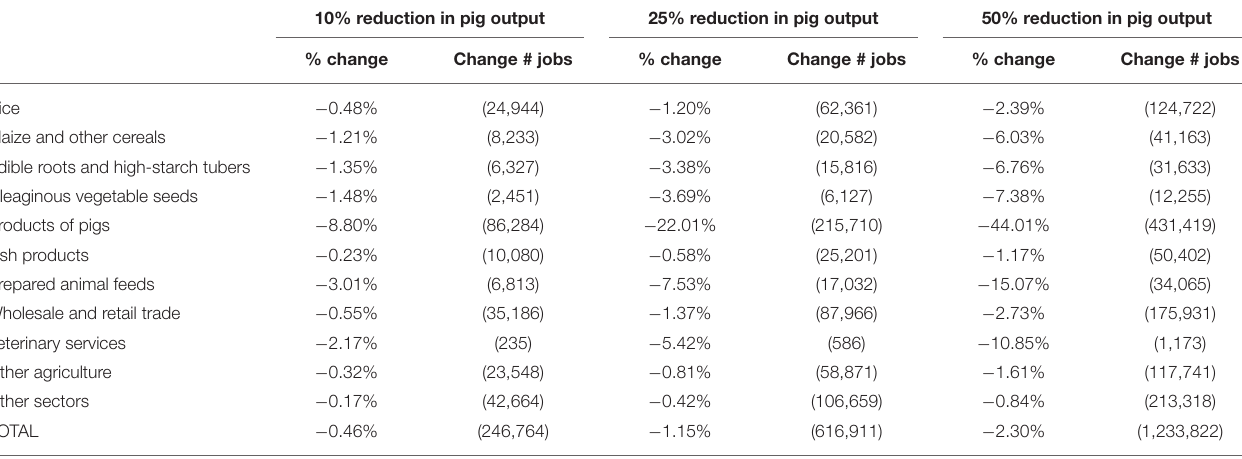
TABLE 5 | Employment impacts of ASF in selected sectors under alternative scenarios.